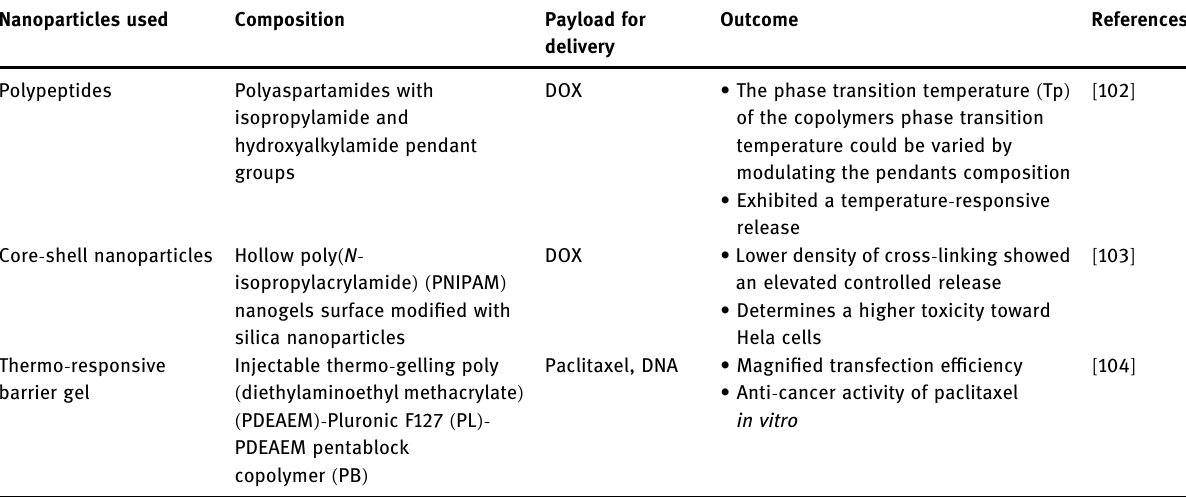
Table 6: Temperature - responsive DDS for mono and combination cancer therapy Nanoparticles